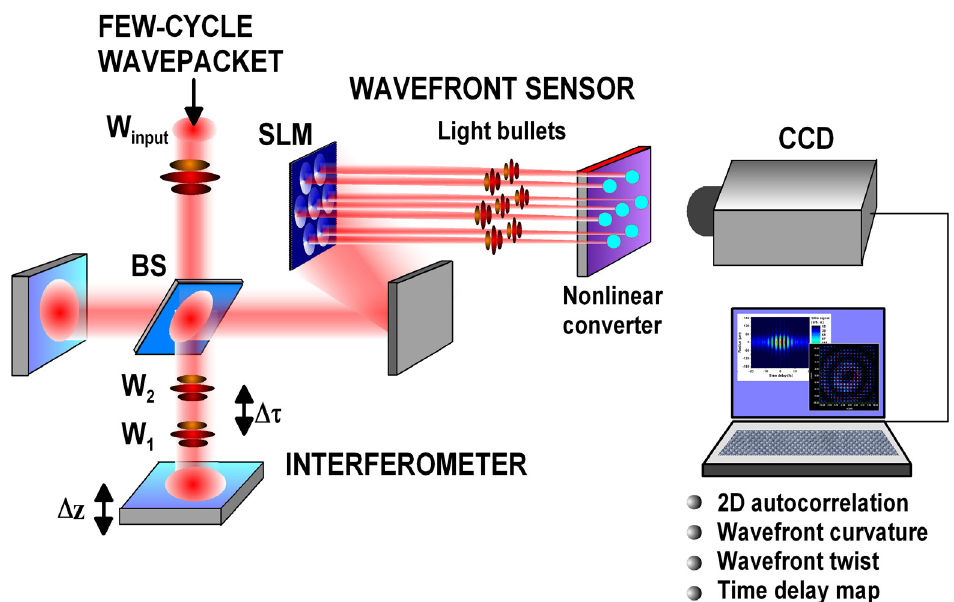
Figure 4. Experimental setup for adaptive shaping and detection of paraxial linear few-cycle light bullets (schematically). For collinear autocorrelation, a balanced interferometer generates two identical replica of the pulse. The variable time delay ( Δ τ ) is induced by the length variation ( Δ z ) of the interferometer arm with a piezo actuator. The SLM shapes the light bullets in finite but extended zones of stable nondiffracting propagation. The combination with second order nonlinear conversion and 2D detection enables to extract spatially resolved pulse duration via image autocorrelation, as well as wavefront curvature, vortex characterization, and highly resolved time delay